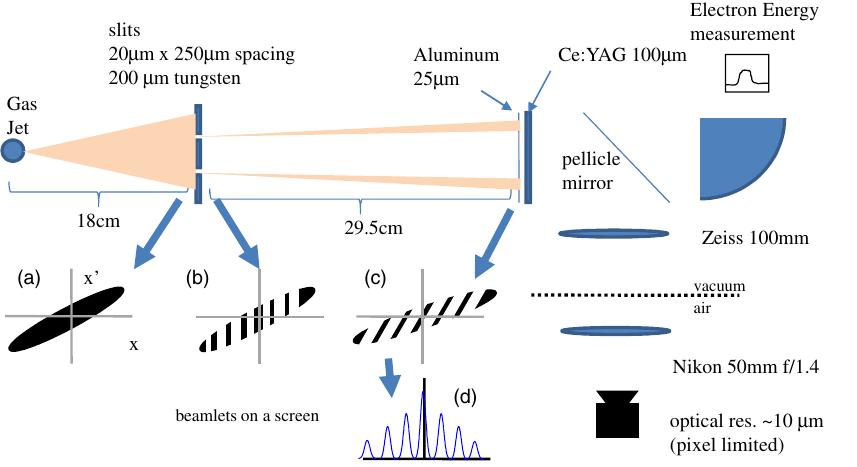
FIG. 1. Layout of the pepper-pot emittance diagnostic. Also shown is the evolution of the transverse phase space: before the mask (a), the beamlets cut out by the mask (b), after propagation in a drift (c), and the profile observed on the screen